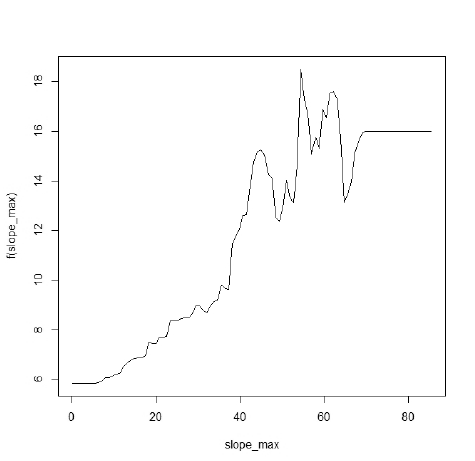
Figure 5: The PDP for slope_max reveals the feature’s increasing impact on the response. Especially, after 40 units, the feature has a hazardous effect on the center line position.